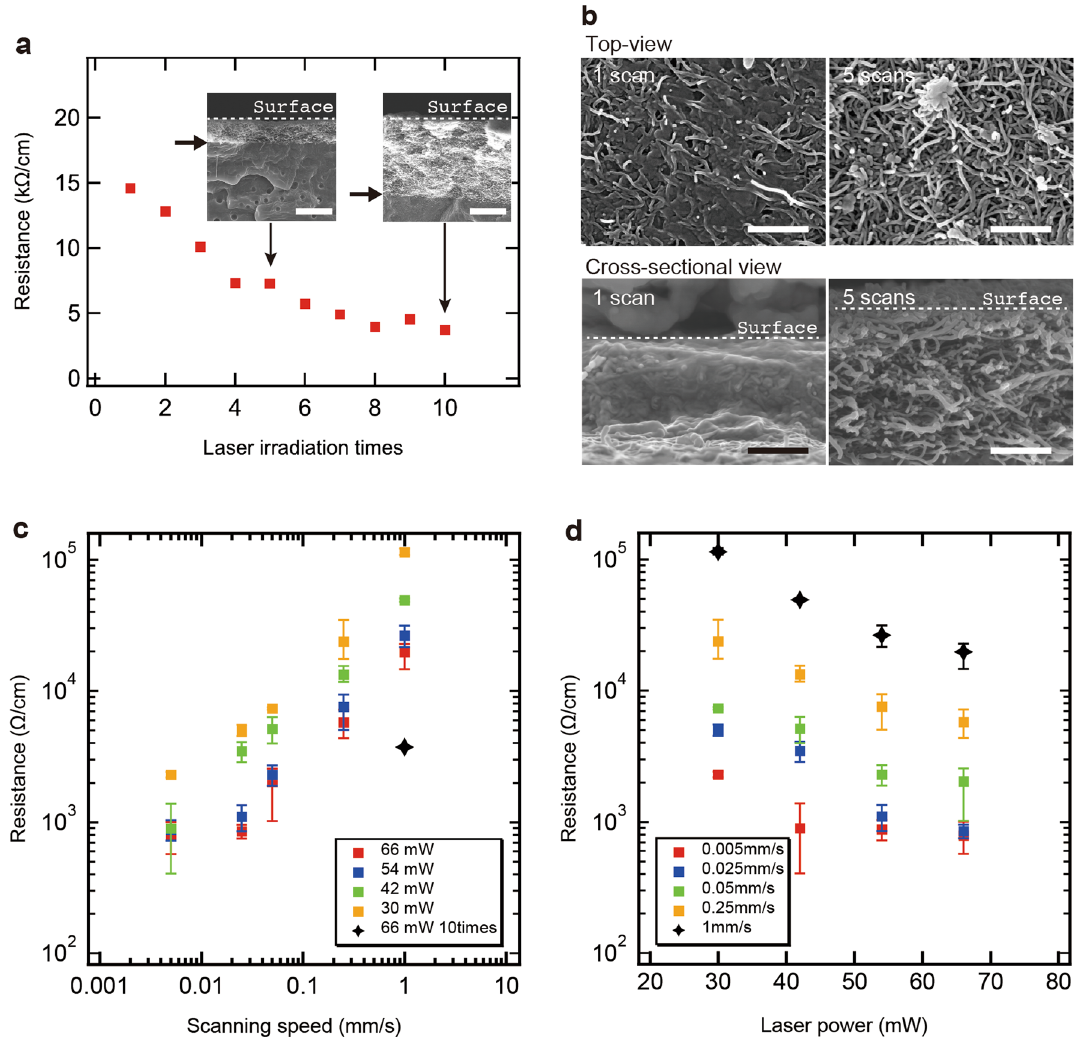
Figure 2. ( a ) Resistance per cm as a function of laser irradiation time (laser power 66 mW and scanning speed 1 mm/s). The insets show the cross-sectional SEM images of the samples after 5 and 10 scans. Scale bars are 2 μm. ( b ) Top-view and cross-sectional SEM images. Scale bars are 0.5 μm. Resistance per cm as functions of ( c ) scanning speed and ( d ) laser power. Error bars indicate maximum and minimum